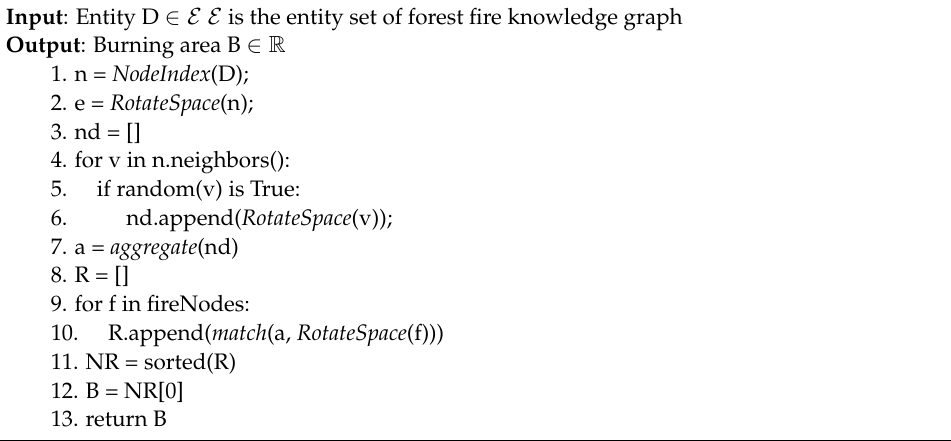
Algorithm 1 : Knowledge-graph and representation-learning-based forest fire